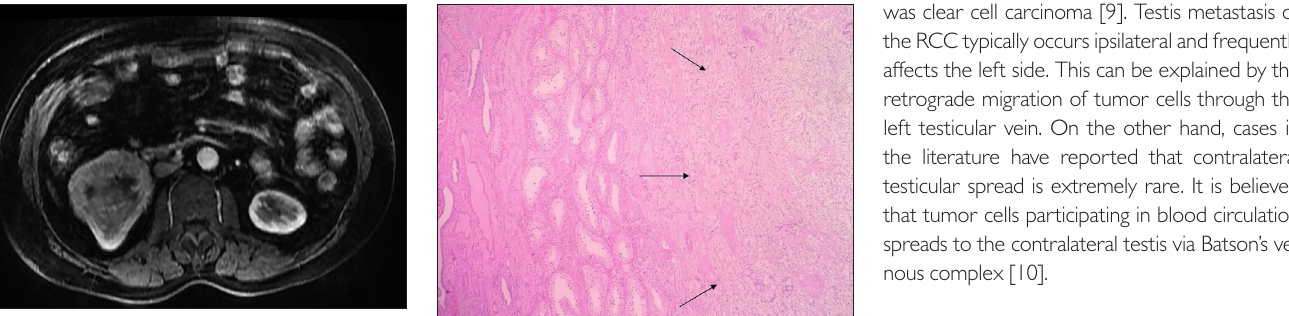
Figure 1. Magnetic resonance imaging of the abdomen revealed a tumor mass with a diameter of 7 cm in the right kidney.